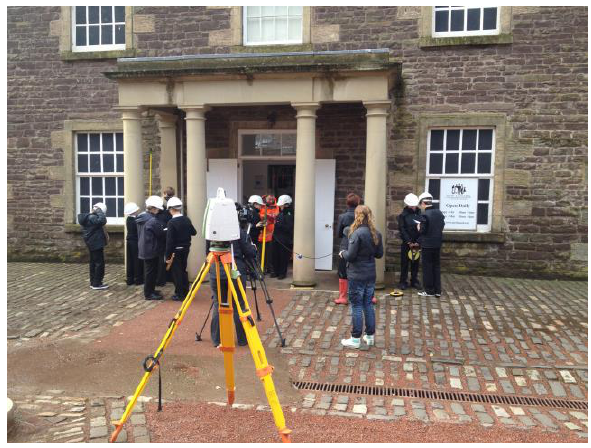
Figure 5. Schools workshop on 3D survey and design at New Lanark © CDDV